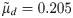
Required sample size for 90% Power, or Pr(Success) = 61%.Suppose the anticipated effect size is μ˜d=0.205, the anticipated variance is σ˜2=1 and the equivalence margin is pre-specified with Δ = 0.1025 (= 12μ˜d). Then, based on the desire for Pr(positive) = 90% (i.e. “power” = 0.90) (dashed blue lines) or a 61% “probability of success” (solid red lines) a sample size of n = 1,000 (with n1 = n2) would be required. If the true variance is slightly larger than anticipated, σ2 = 1.25, and the effect size smaller, μd = 0.123, the actual sample size needed for 90% power is in fact 3,476, while the actual sample size needed for Pr(success) = 61% is 1,770; see points “a1” and “a2”. On the other hand, if the true variance is slightly smaller than anticipated, σ2 = 0.75 and the effect size greater, μd = 0.33, the actual sample size needed for 90% power is only 288, while the actual sample size needed for Pr(success|δ, d, s) = 61% is 638; see points “b1” and “b2”.